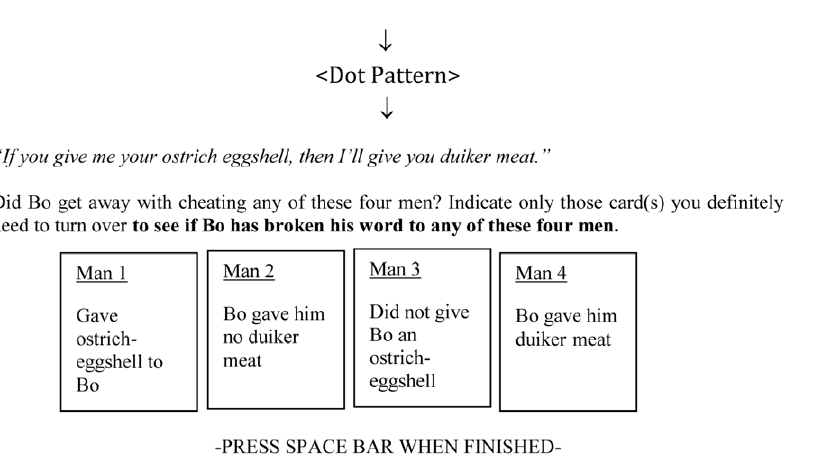
Figure 3. Social contract version in Experiment 3 with the sequence of the screens as presented to the participants.